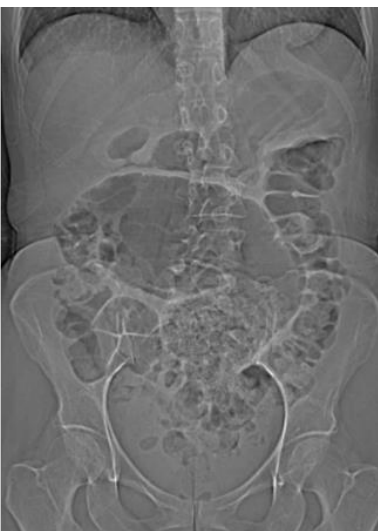
Figure 3. CT topogram demonstrating classical features of a caecal volvulus.